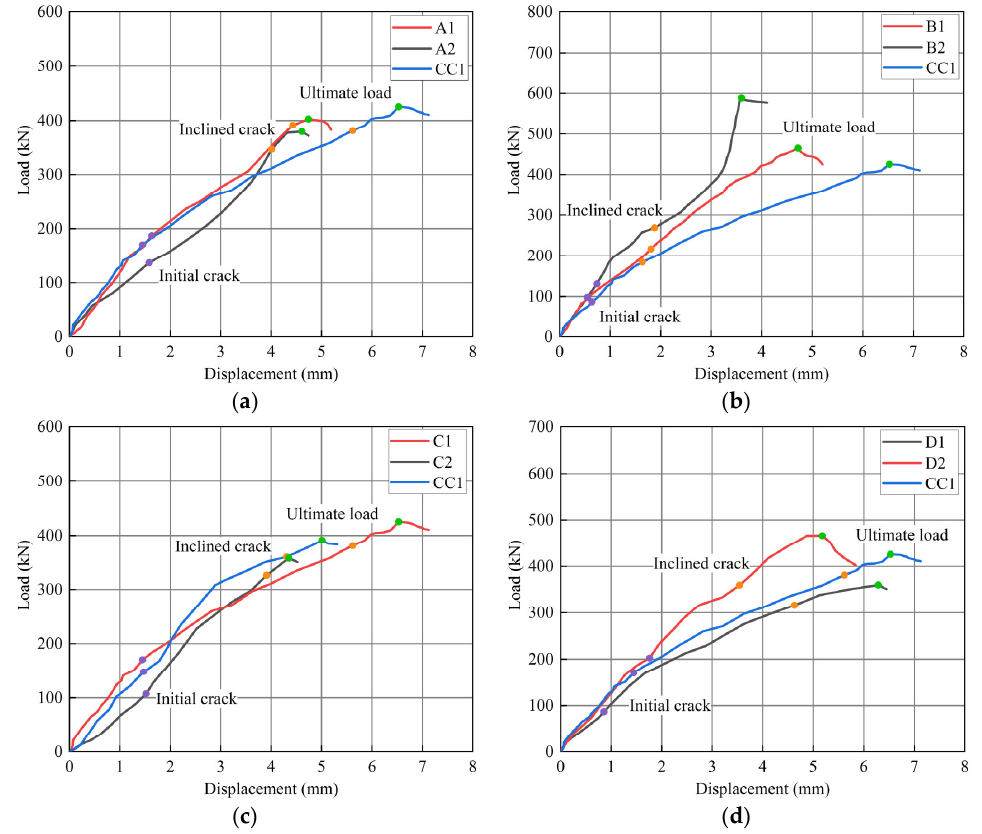
Figure 7. Load–displacement curves with ( a ) DS replacement ratio; ( b ) shear span-to-depth ratio; ( c ) stirrup ratio; ( d ) concrete strength.